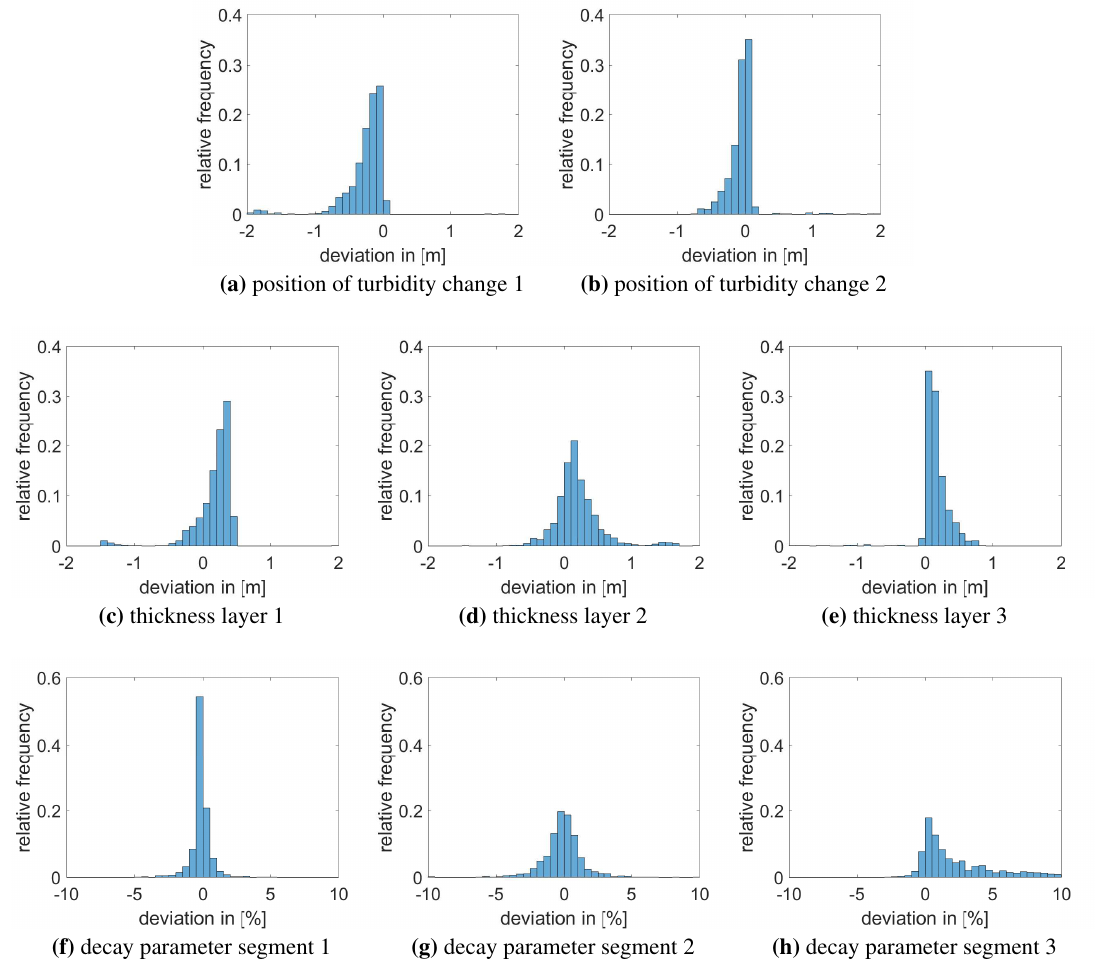
Figure 10. Deviation between reference values known from the simulation and actual values estimated by segment-wise exponential function